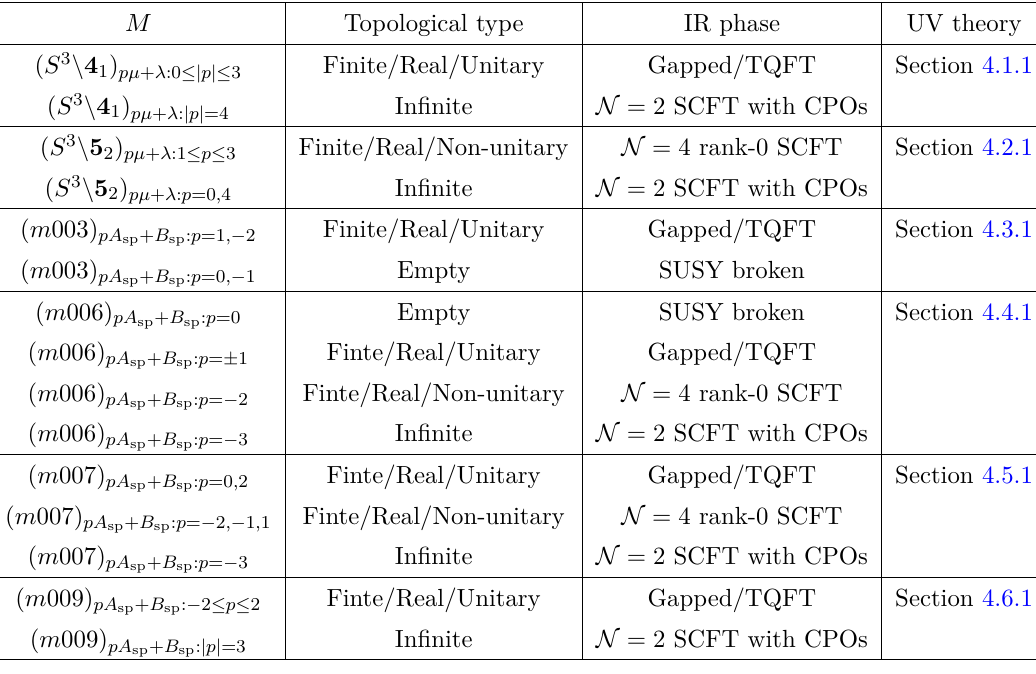
Table 1 . IR phases of class R theories associated to non-hyperbolic 3-manifolds obtained by exceptional Dehn fillings on S 3 \ 4 003 , m 006 , m 007 and m 009 . 3 \ 5 1 , S 2 , m The T [ S 3 \ 4 which is enhanced to SU(3) at IR [13, 46, 47]. , µ ; λ ] has SU(2) × U(1) 1 top Φ